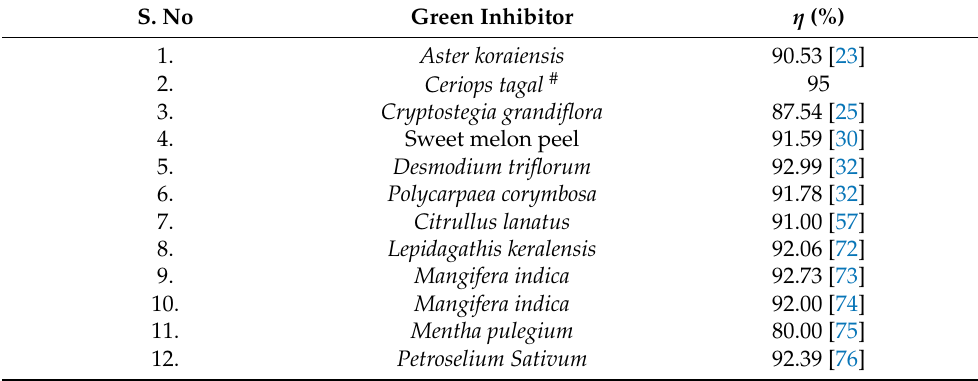
Table 5. Comparison of C. tagal (present) green inhibitor over other green